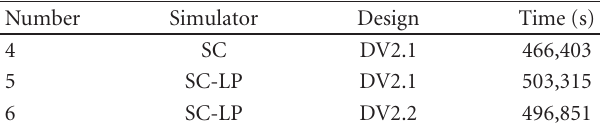
Figure 9: Waveforms.